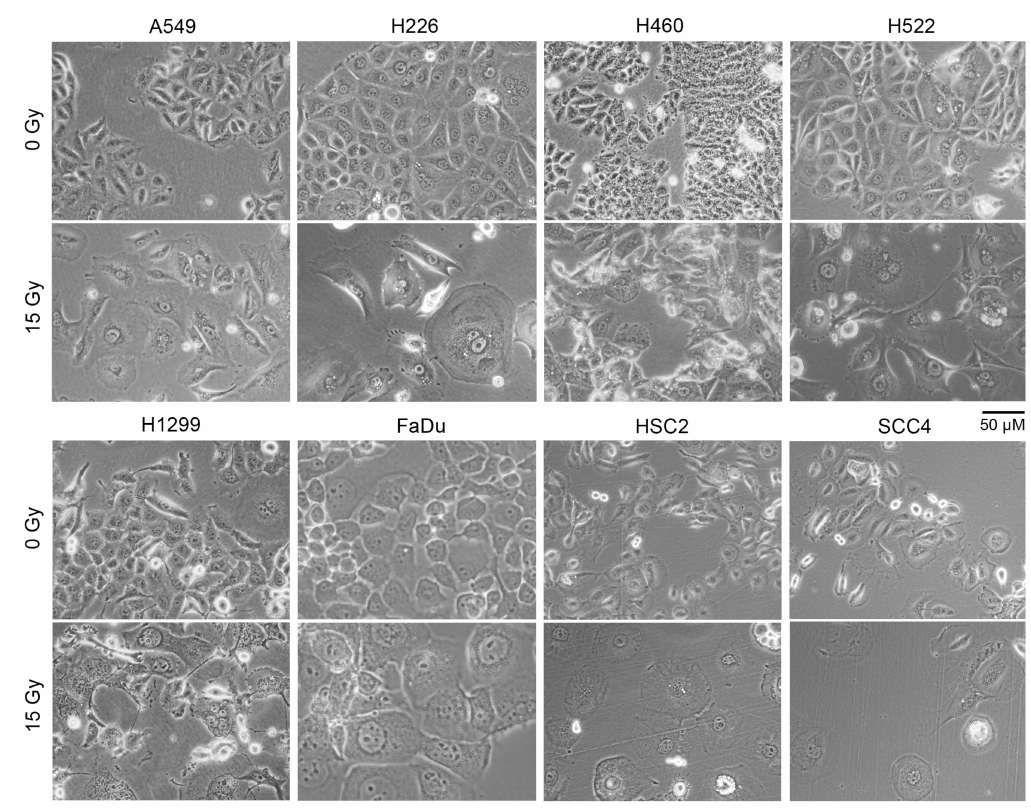
Figure 3. Cell size increased following radiation treatment. Indicated human cancer cell lines were treated with one dose of 15 Gy X-rays or left untreated (0 Gy). Shown are representative phase contrast light microscopy images of cells after four days. Floating cells were removed before imaging.